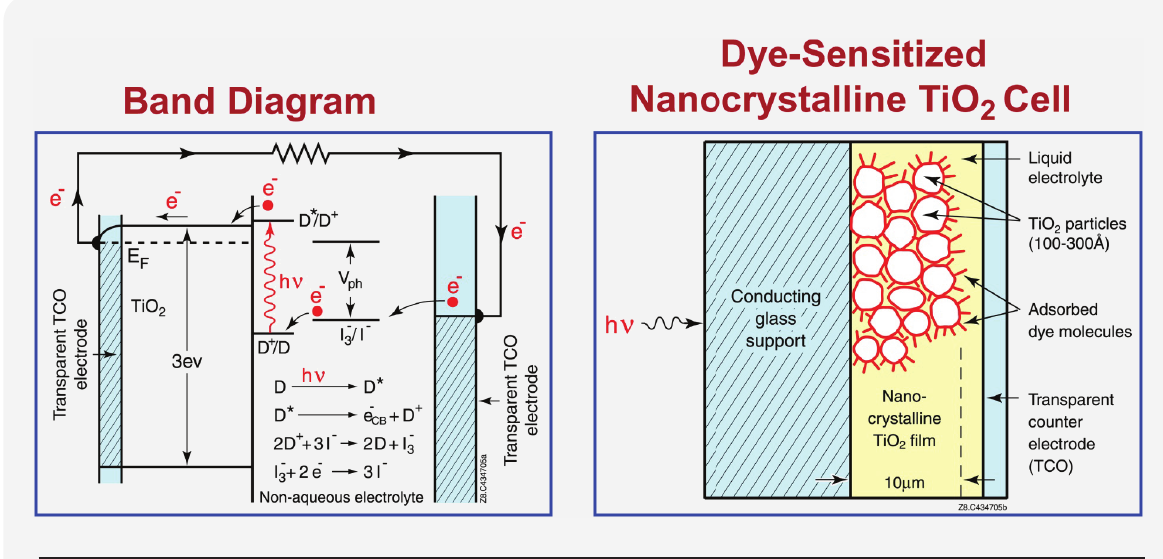
Figure 3. A schematic representation of the Grätzel cell. Reprinted by permission from Springer Nature: Michael Grätzel, Photoelectrochemical cells, Nature Vol. 414, pages 338–344 (15 November